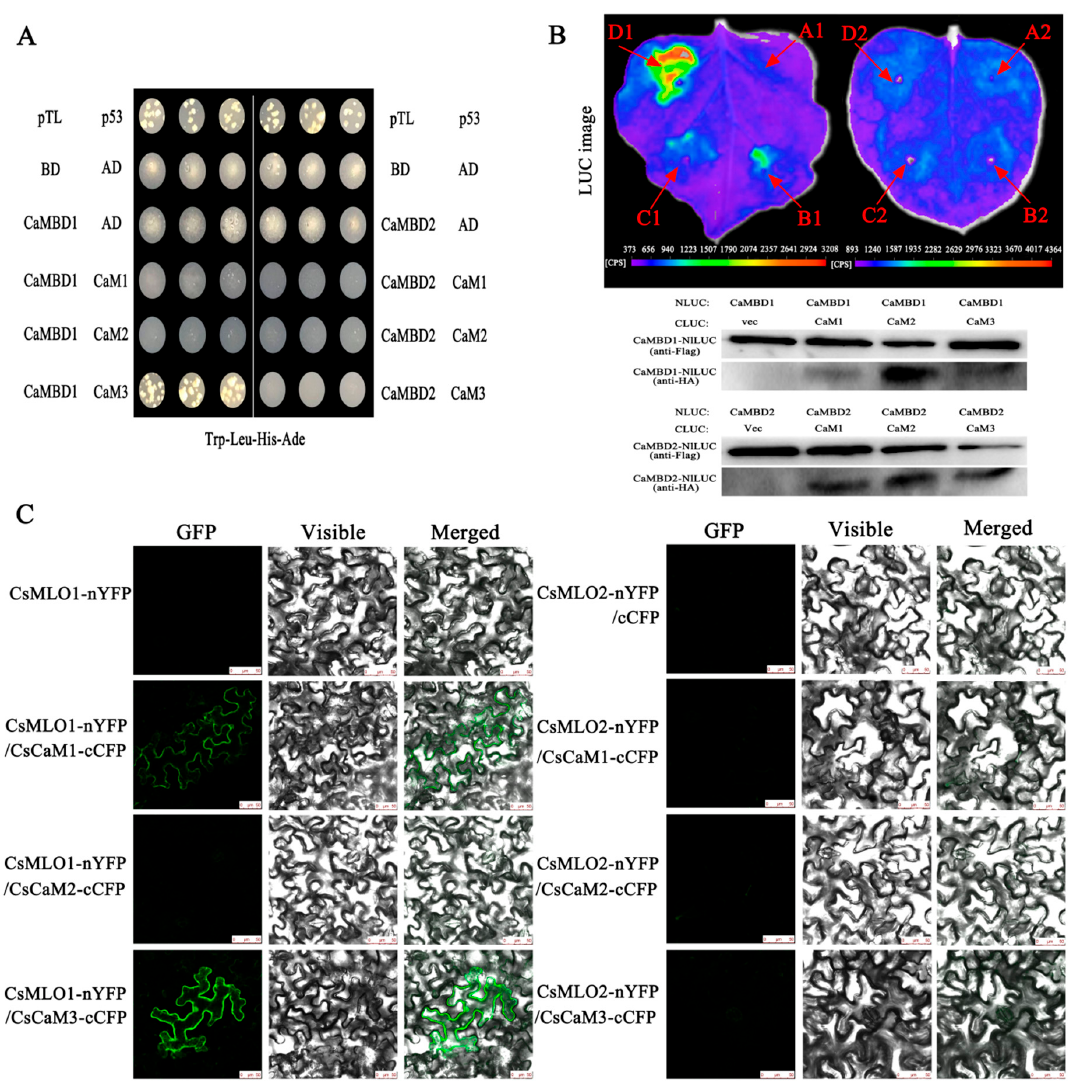
Figure 4. CsMLO interacts with CsCaM in yeast and N. benthamiana epidermal cells. ( A ) BD / CsMLO1 or BD / CsMLO2 interacts with AD / CaM1, AD / CaM2, and AD / CaM3 on synthetic dropout medium lacking Trp-Leu-His-Ade in the yeast two-hybrid system. BD, bait; AD, prey; and p53 / pTL, positive control. ( B ) Firefly luciferase complementation (LUC) imaging assay and western blot analysis of the interaction between CsMLO and CsCaM in N. benthamiana leaves. Arrows indicate leaf panels that were infiltrated with Agrobacterium containing the indicated constructs. A1: cLUC + CaMBD1-nLUC; B1: cLUC-CaM1 + CaMBD1-nLUC; C1: cLUC-CaM2 + CaMBD1-nLUC; D1: cLUC-CaM3 + CaMBD1-nLUC; A2: cLUC + CaMBD2-nLUC, B2: cLUC-CaM1 + CaMBD2-nLUC, C2: cLUC-CaM2 + CaMBD2-nLUC; and D2: cLUC-CaM3 + CaMBD2-nLUC. The western blot below shows the expression levels of cLUC- and nLUC-fusion proteins. ( C ) Bimolecular fluorescence complementation (BiFC) analysis of the interaction with CsMLO1 / CsCaM1, CsMLO1 / CsCaM2, CsMLO1 / CsCaM3, CsMLO2 / CsCaM1, CsMLO2 / CsCaM2, and CsMLO2 / CsCaM3 in N. benthamiana leaves infiltrated with Agrobacterium . (Left) Reconstitution of YFP-derived fluorescence. (Middle) Bright field images. (Right) Merged fluorescence images. (Scale bar: 50 μ m.).